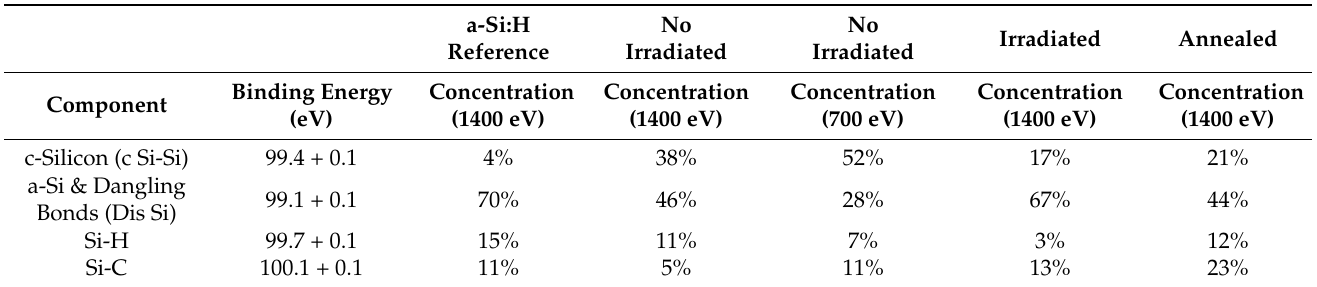
Table 1. Area of the Si2p components and Si2p 3/2 BE, according to the deconvolutions shown in Figure 4. The concentrations are referred to as the Si2p components in the film (see